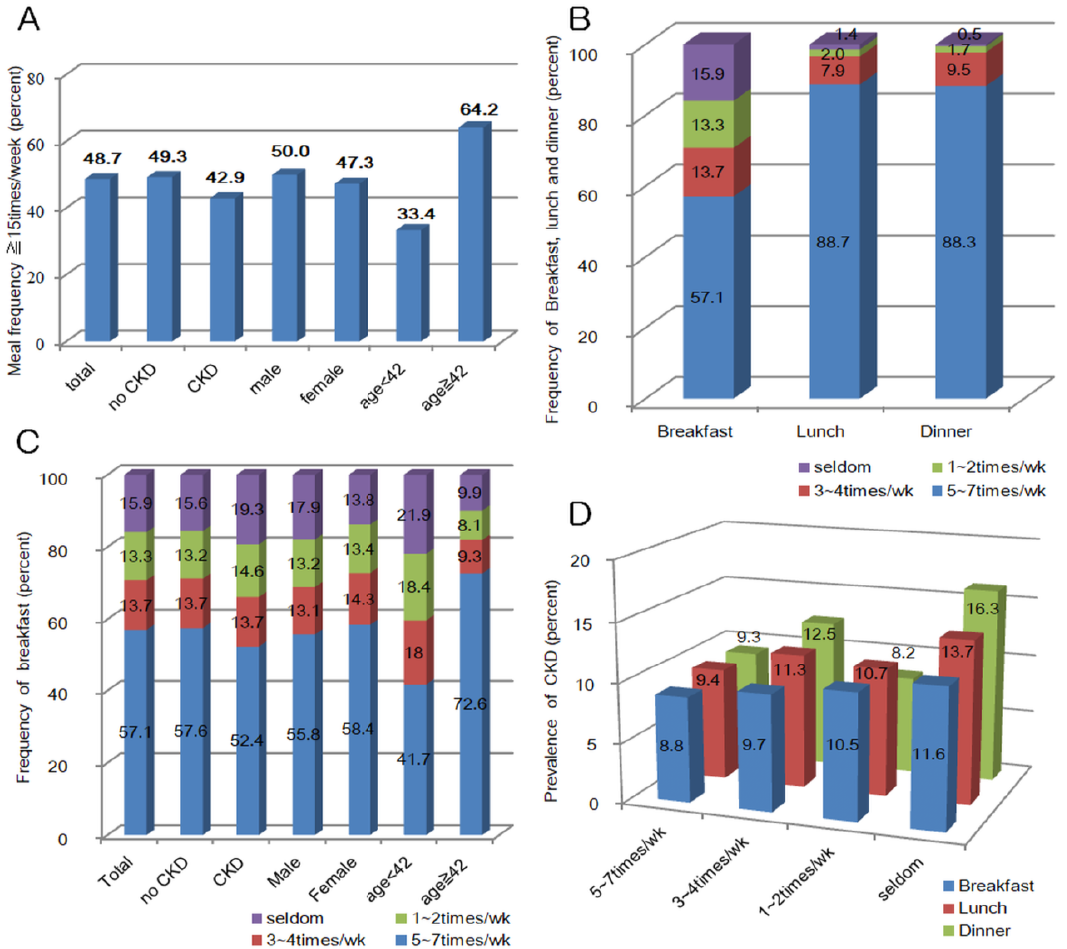
Figure 2. ( A ) Meal frequency at least ≥ 15 times/week; ( B ) frequency of breakfast, lunch and dinner; ( C ) frequency of breakfast by chronic kidney disease (CKD), gender, and age (years); and ( D ) prevalence of CKD by the frequency of breakfast, lunch, and dinner.